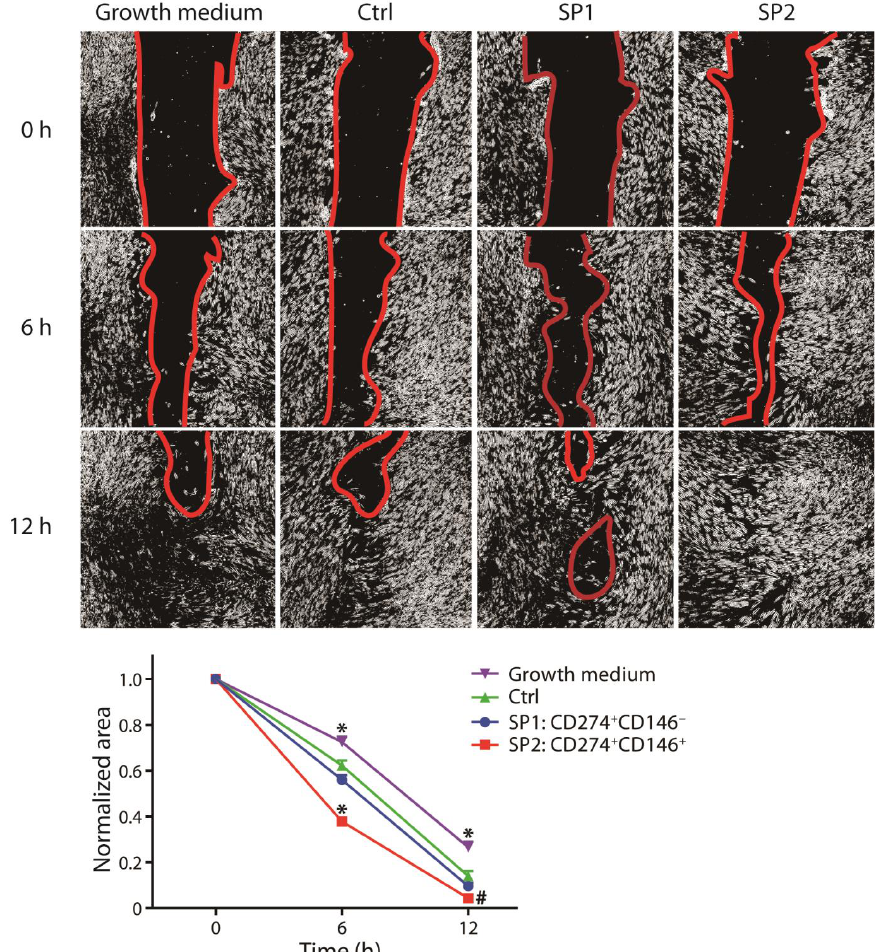
Figure 5. Capacity of fractions sorted and expanded from the thawed ASC passage P4 to promote the wound healing. The closure of the scratch wound in the fibroblast monolayer upon stimulation with different supernatants was monitored using phase contrast microscopy and quantitated by micromorphometric analysis. The complementary phenotype to the one indicated for the SP1 and are presented as a mean + SEM from two independent experiments ( n = 23). *, statistically significant difference from other groups at p < 0.05; and #, statistically significant difference from Ctrl and the growth medium at p < 0.05. Abbreviations: SP, subpopulation; Ctrl,